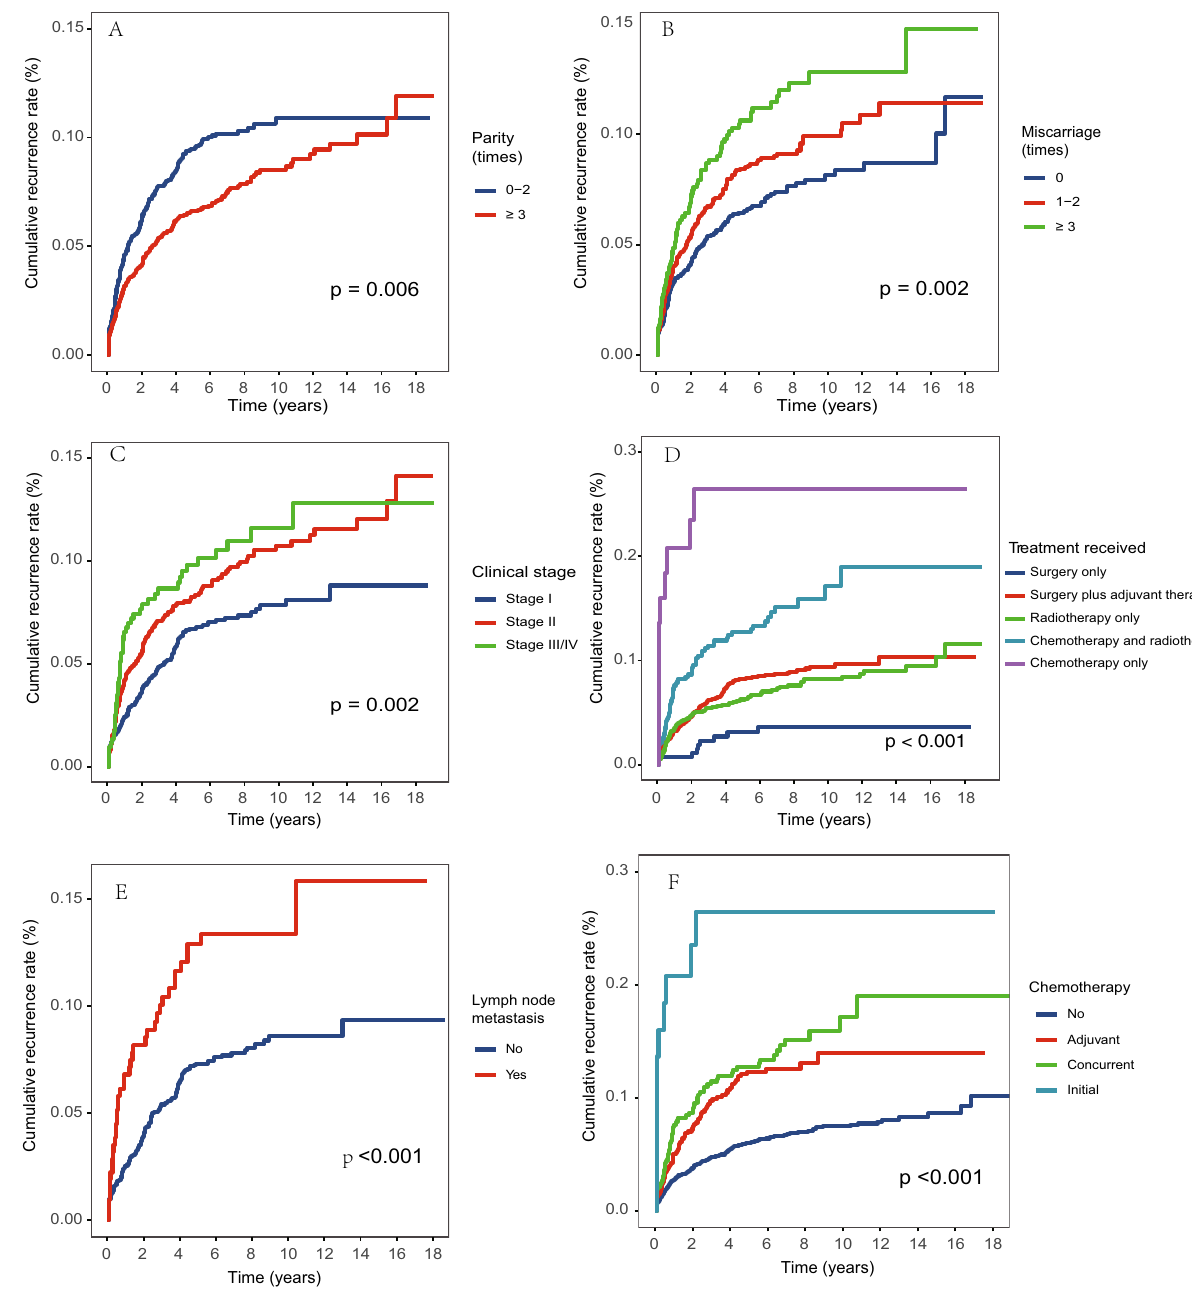
Figure 2. Cumulative recurrence rate by ( A ) parity; ( B ) miscarriage; ( C ) clinical stage; ( D ) treatment received; ( E ) lymph node metastasis; ( F )